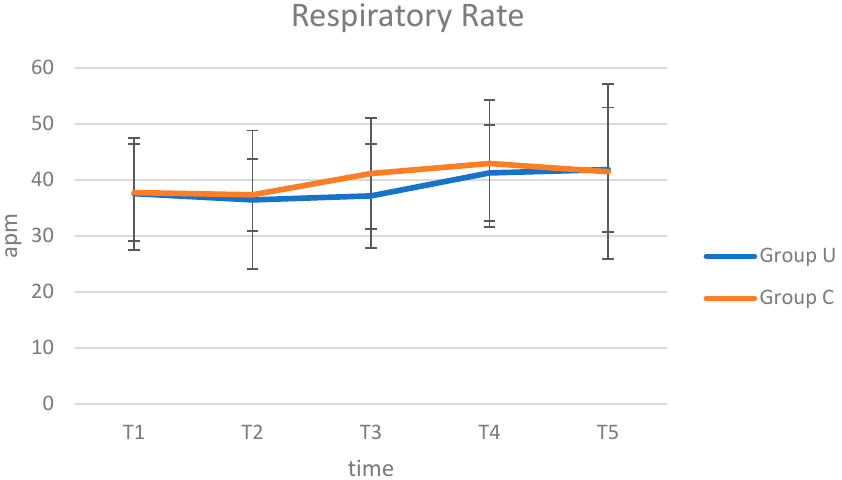
Figure 4. Average values of RR (apm), values in Group U (pigs underwent ultrasound examination before cryptorchidectomy) and Group C (control group, without ultrasonography), at times T1 (surgical preparation, after placing the animal on the operating table and inducing anaesthesia), T2 (skin incision), T3 (manipulation of the testicle), T4 (resection of the testis and release of residual stump of the spermatic cord), and T5 (end of surgery, after applying the last simple stitch on the skin).